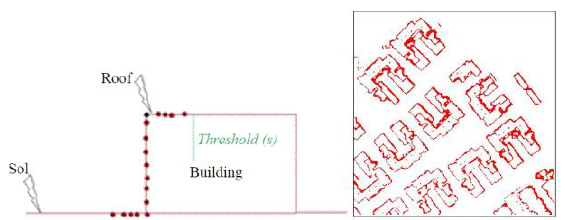
Figure 3: Automatic extraction of upper contour